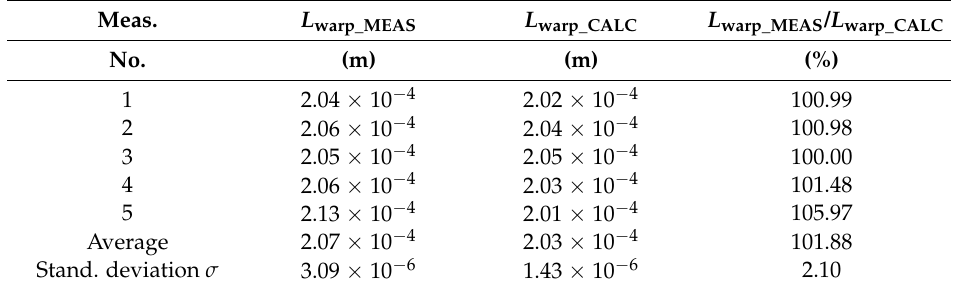
Table 7. The comparison of measurement and calculated results of the length of the warp-RSKCuIv4. Meas.